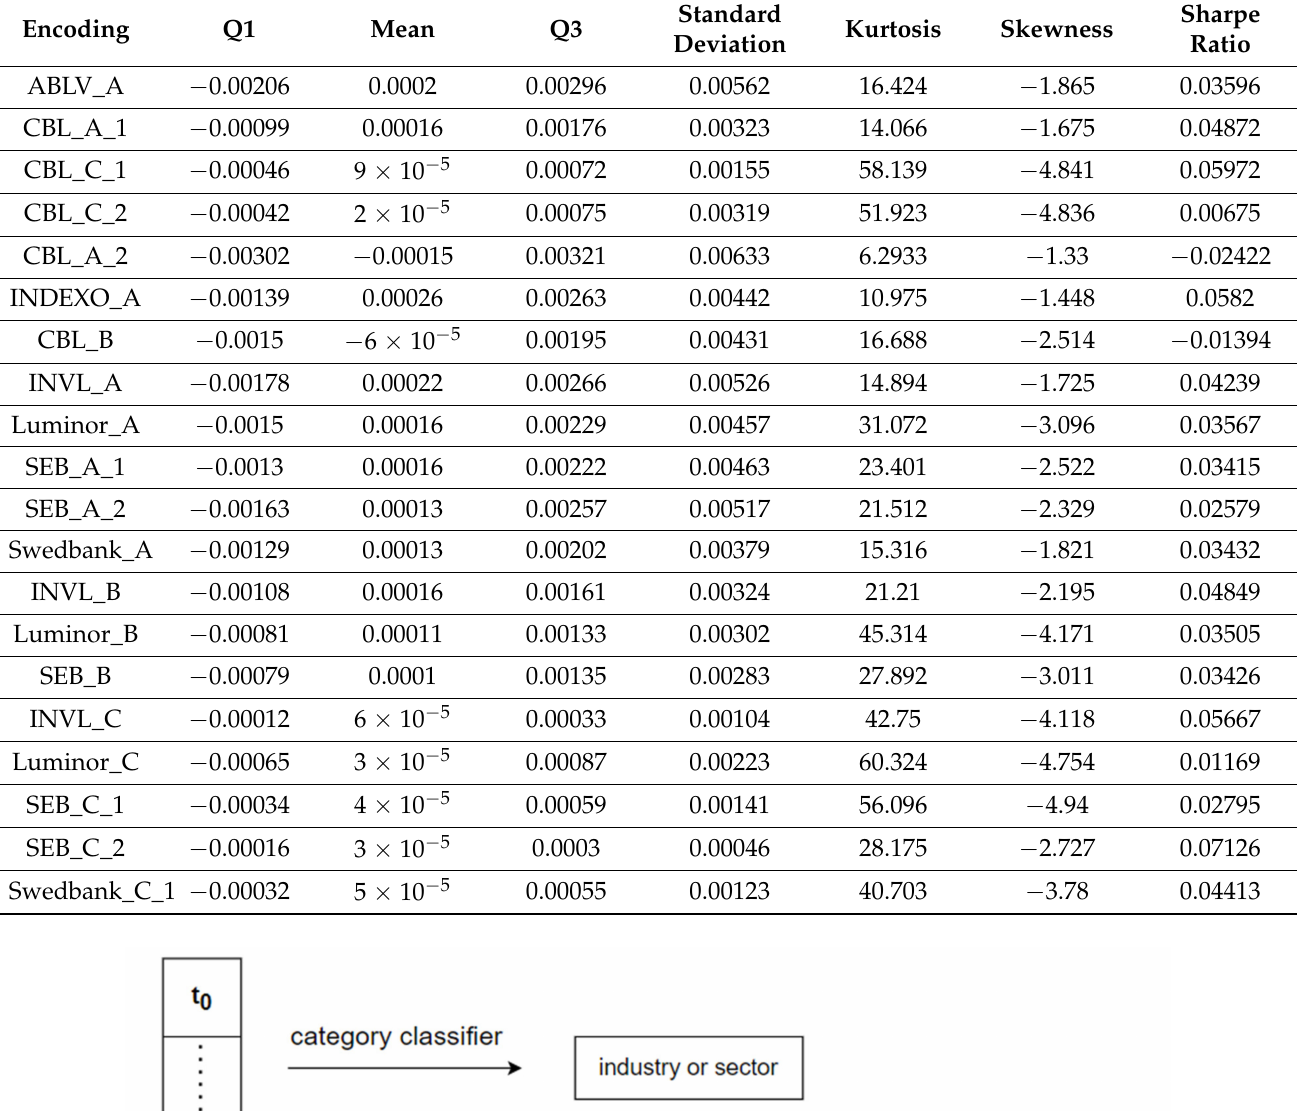
Table 2. Statistical analysis of pension fund returns.